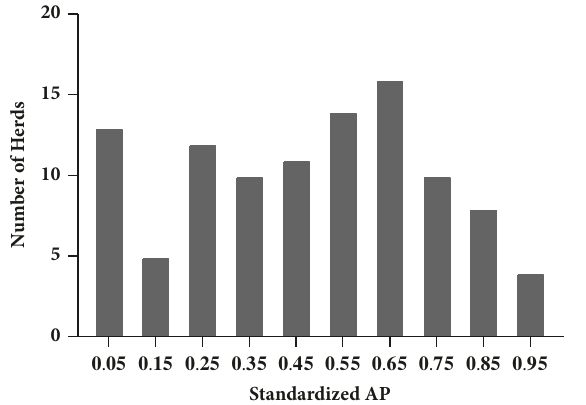
Figure 3: Distribution of standardized AP by state; significant ANOVA (p=0.025); no significant pairwise comparisons. For box- plots: + symbol=mean, midline=median, shaded box=interquartile range (where n > 3), whiskers=min and